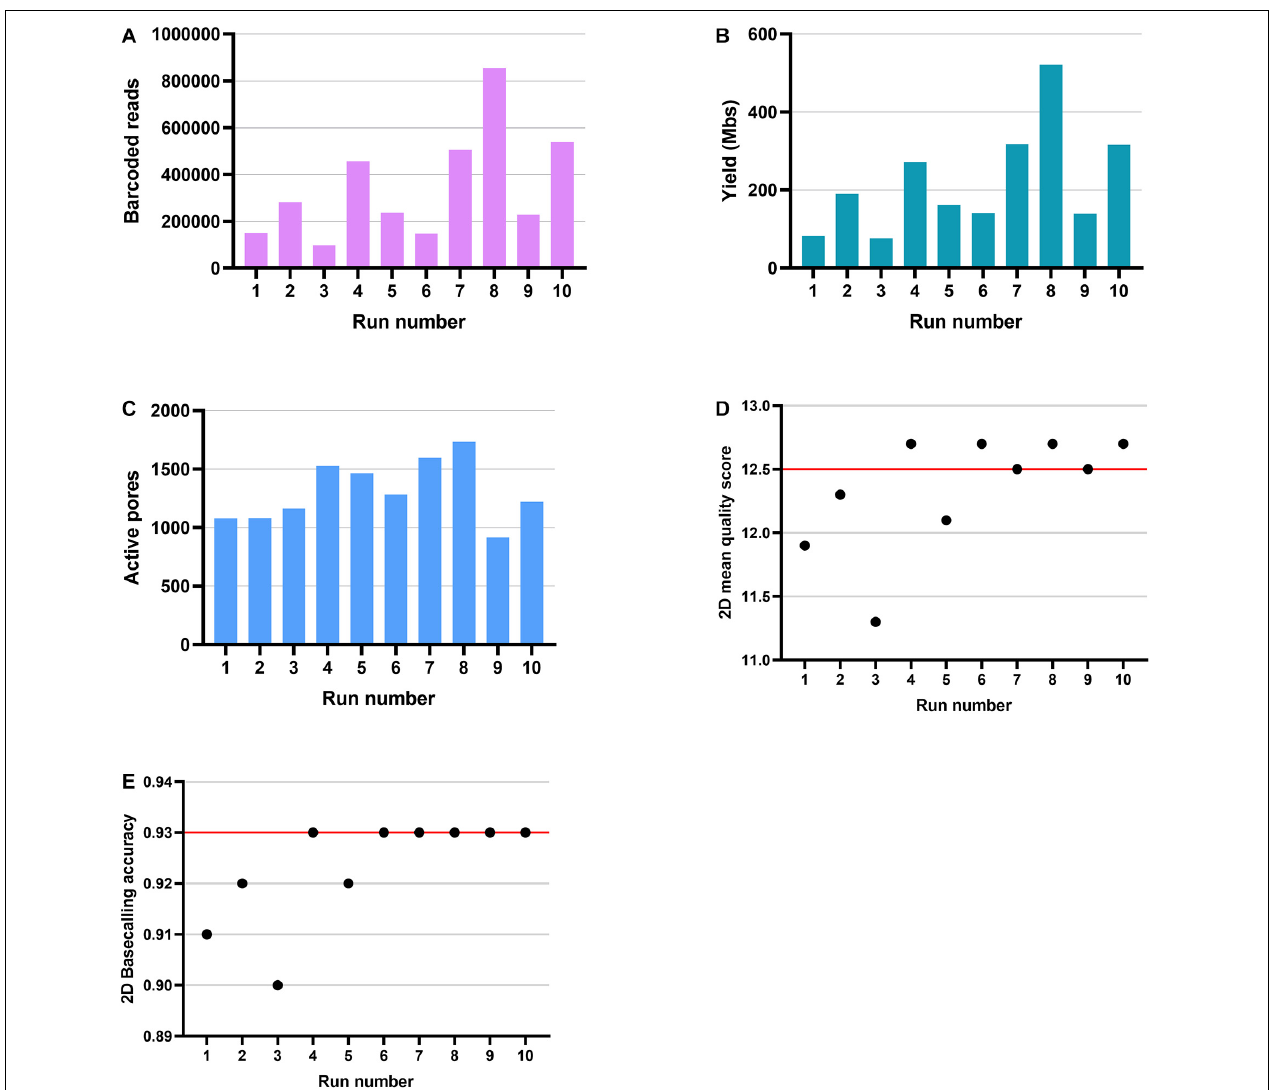
FIGURE 2 | Produced data and quality metrics of ONT MinION sequencing runs. Ten MinION flow cell produced between 97,595 and 855,489 barcoded reads (A) and yielded between 76.33 and 521.45 Mbases (B) . The number of active pores identified in each run ranged from 915 to 1,732 (C) . The distribution for 2D mean quality score was 11.3–12.7 (D) and 0.90–0.93 for 2D basecalling accuracy (E) . The red lines indicate the median.